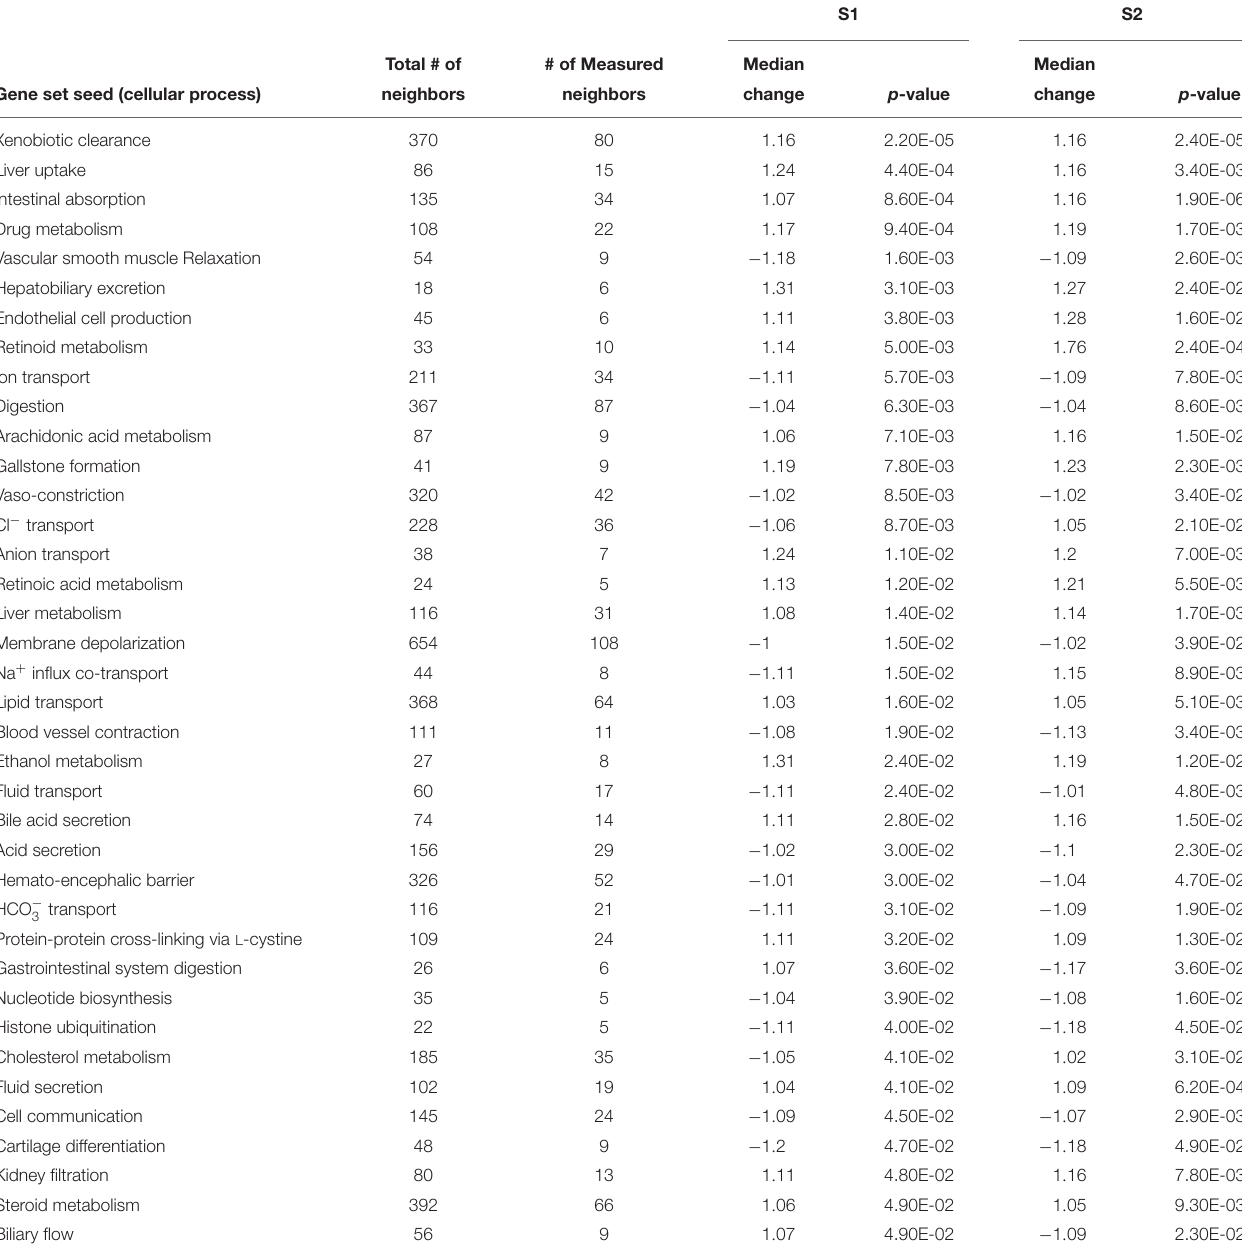
TABLE 3 | Sub-network enrichment analysis (SNEA) for common cellular processes in S. tropicalis exposed to S1 and S2 mixtures of